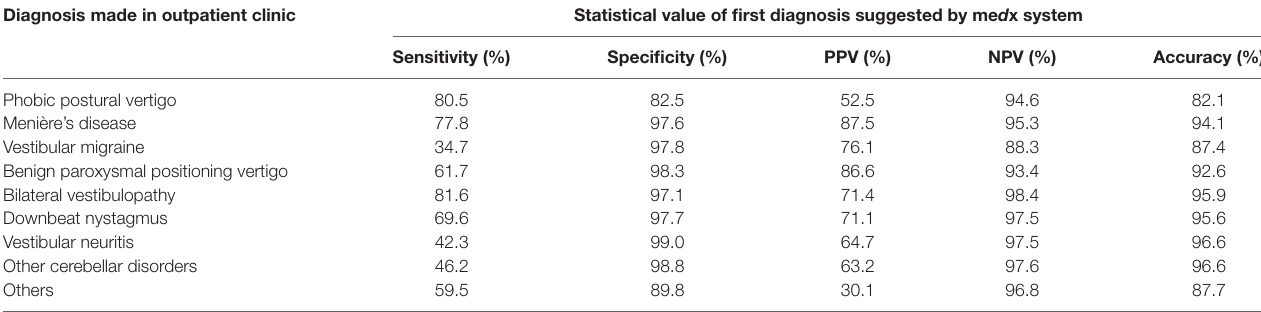
TaBle 4 | Statistical value analyzing me d x system in a one-class problem and taking into consideration the first diagnosis suggested by the me d x